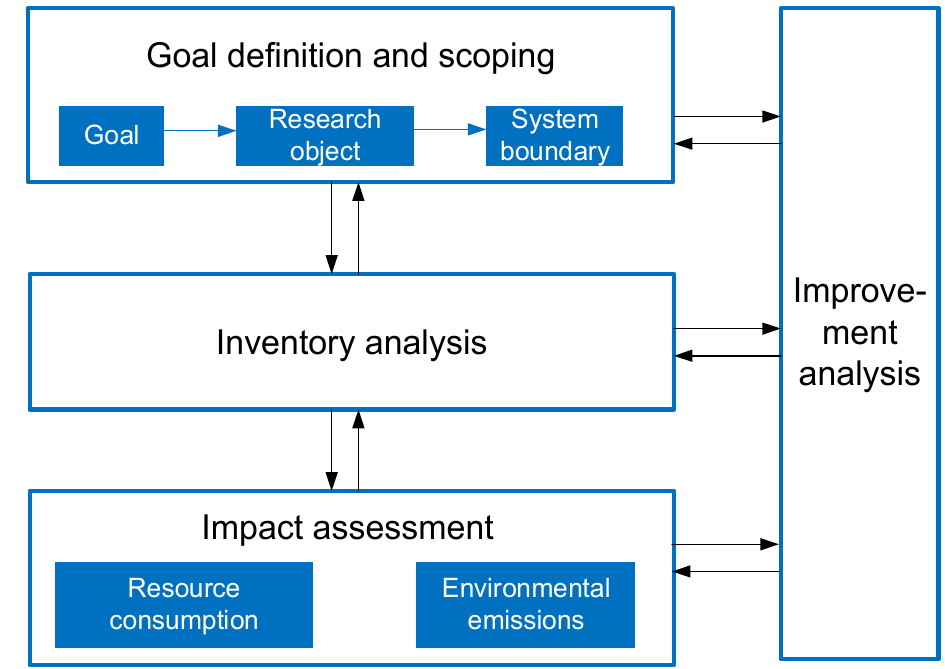
Figure 1. The framework of life cycle assessment (LCA) with four steps.